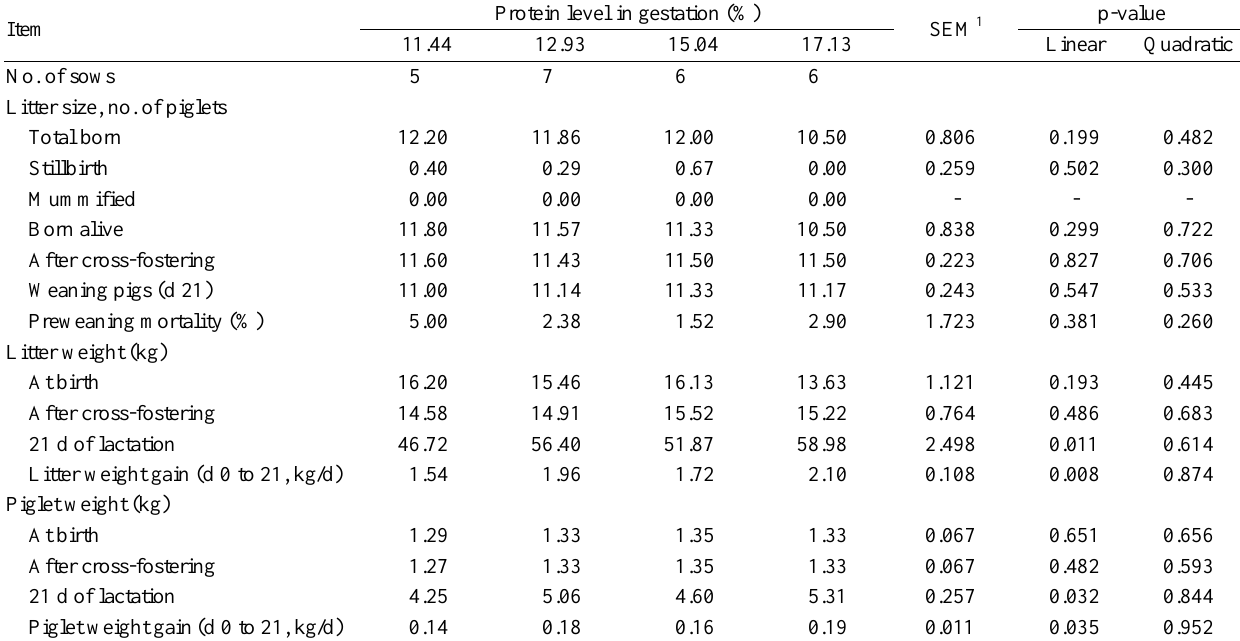
Protein level in gestation (%)